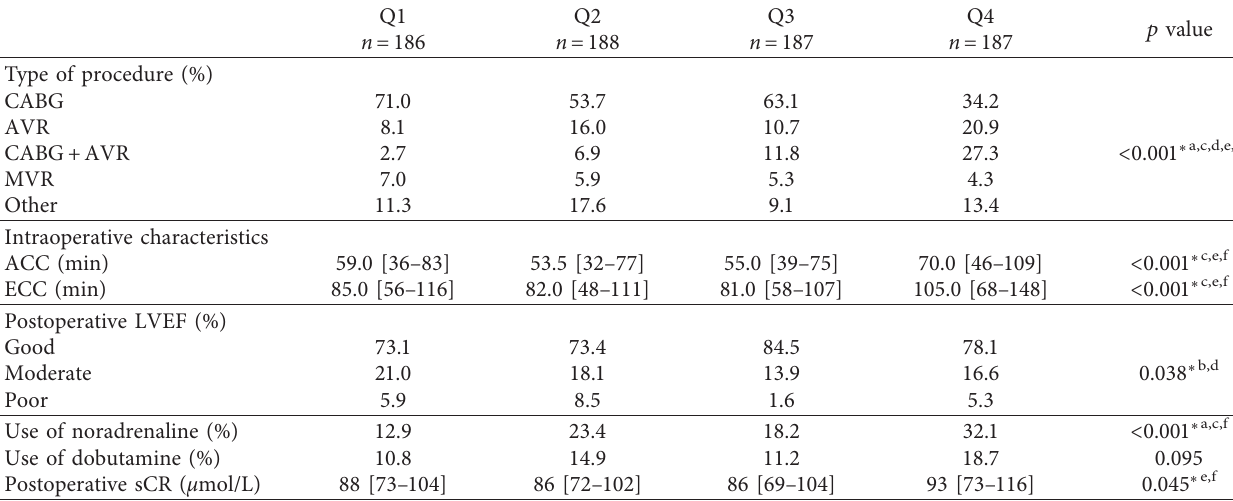
Table 2: Perioperative